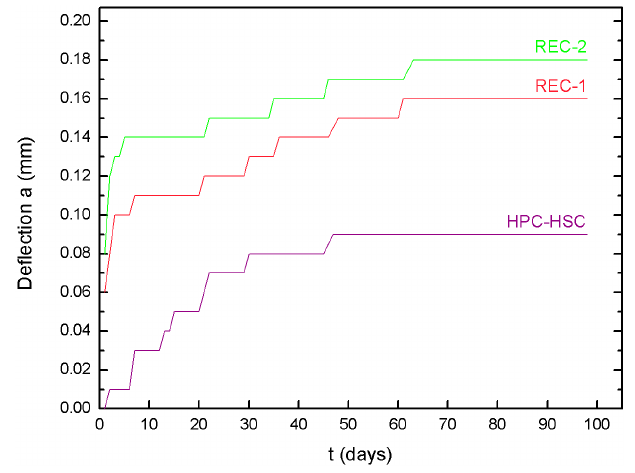
Figure 9. Long-time deflection values for concrete.